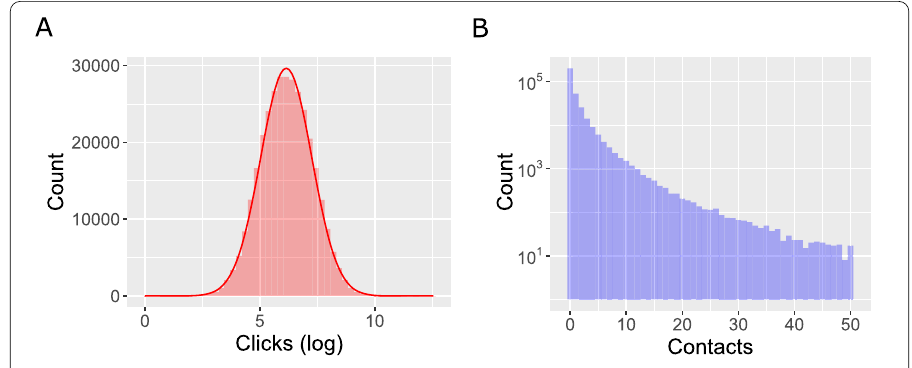
Figure 2 Distribution of the total number of clicks and contacts throughout the lifespan of ads. ( A ) The total number of clicks almost perfectly follows a log-normal distribution (red solid line). ( B ) The total number of contacts follows a heavy-tailed distribution, but only varies over two orders of